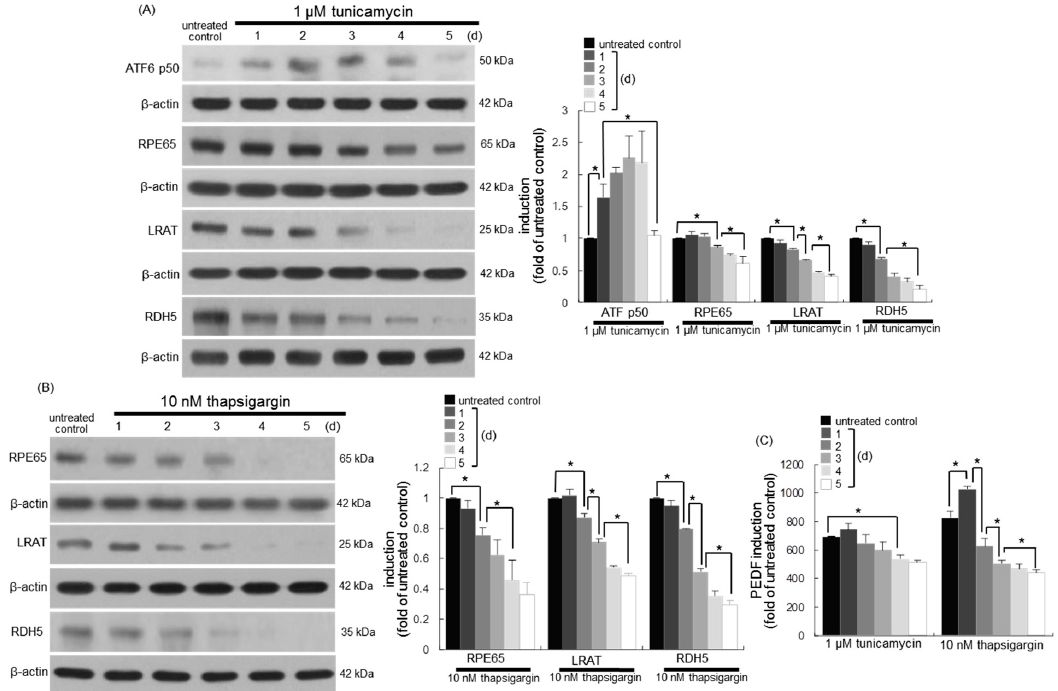
Figure 6. Temporal inhibition of retinal visual cycle enzymes ( A , B ) and PEDF ( C ) in endoplasmic reticulum (ER) stress-faced human retinal pigment epithelial (RPE) cells. RPE cells were incubated in the absence and presence of 1 μ M of tunicamycin and 10 nM of thapsigargin for up to five days. Cell lysates were subject to Western blot analysis with a primary antibody against activating transcription factor 6 (ATF6) p50, RPE65, LRAT, and RDH5 ( A , B ). β -actin protein was used as an internal control. Bar graphs (mean ± SEM, n = nine independent experiments) in the right represent the densitometric results of left blot bands ( A , B ). The secretion of PEDF in RPE cell culture media was measured with an ELISA kit ( C ). *, Values in bar graphs indicate a significant difference at p < 0.05.